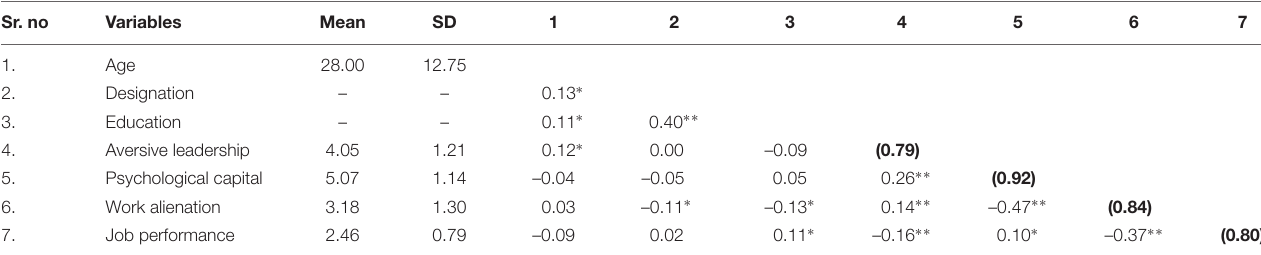
TABLE 2 | Means, standard deviation, correlation, and Cronbach’s α reliabilities of the variables. Sr.